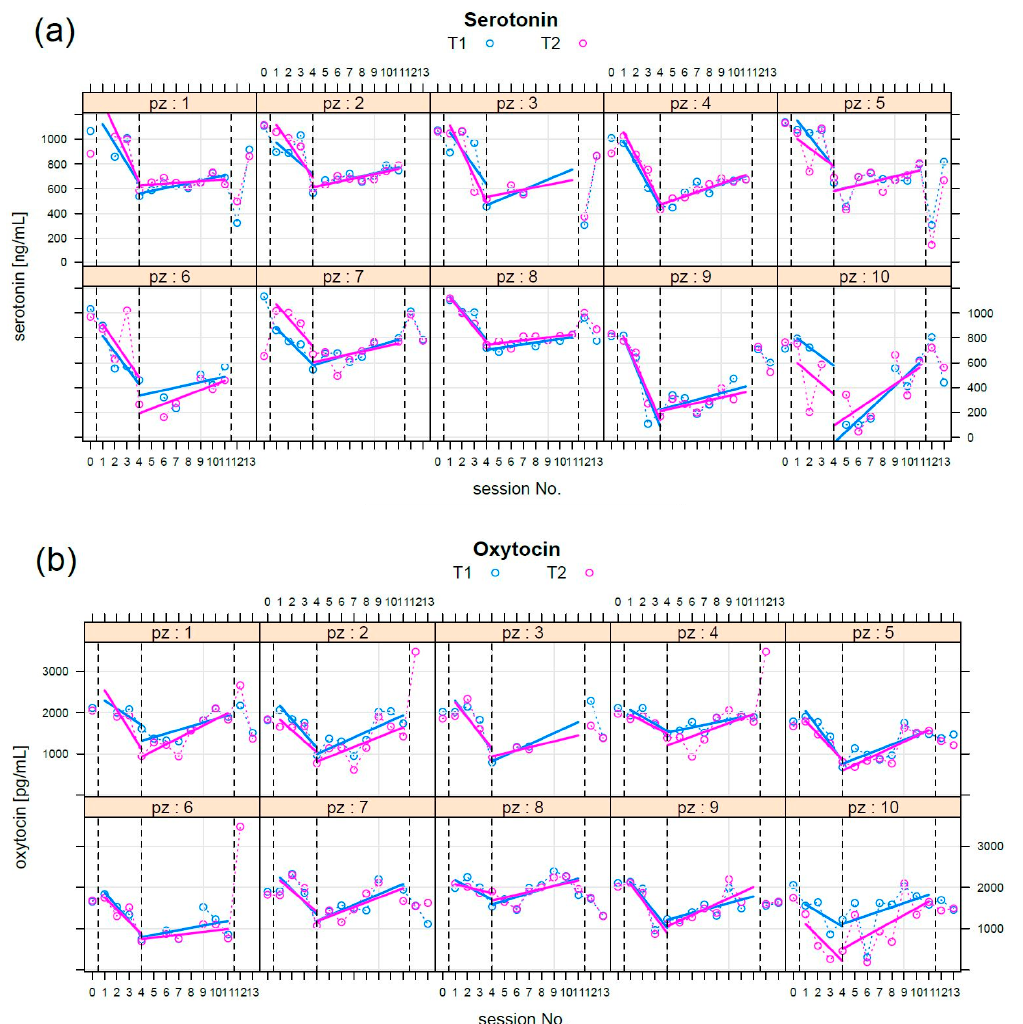
Figure 2. ( a ) Serotonin: per each patient (pz) measurements were reported at T1 (blue circles) and T2 (magenta circles). The first blood sampling had the objective to establish basal levels. The time course of the serotonin level has a clear biphasic shape. During the first phase (sessions 1–4), concentration decreased; during the second phase (sessions 4–11), the level increased. The last two session took place six months apart from session 11, without the dog. Regression lines were superimposed in opportune colours. The vertical dotted lines separate the phases. ( b ) Oxytocin, a biphasic pattern also emerges in this case: the same considerations stated above for serotonin can be repeated here.